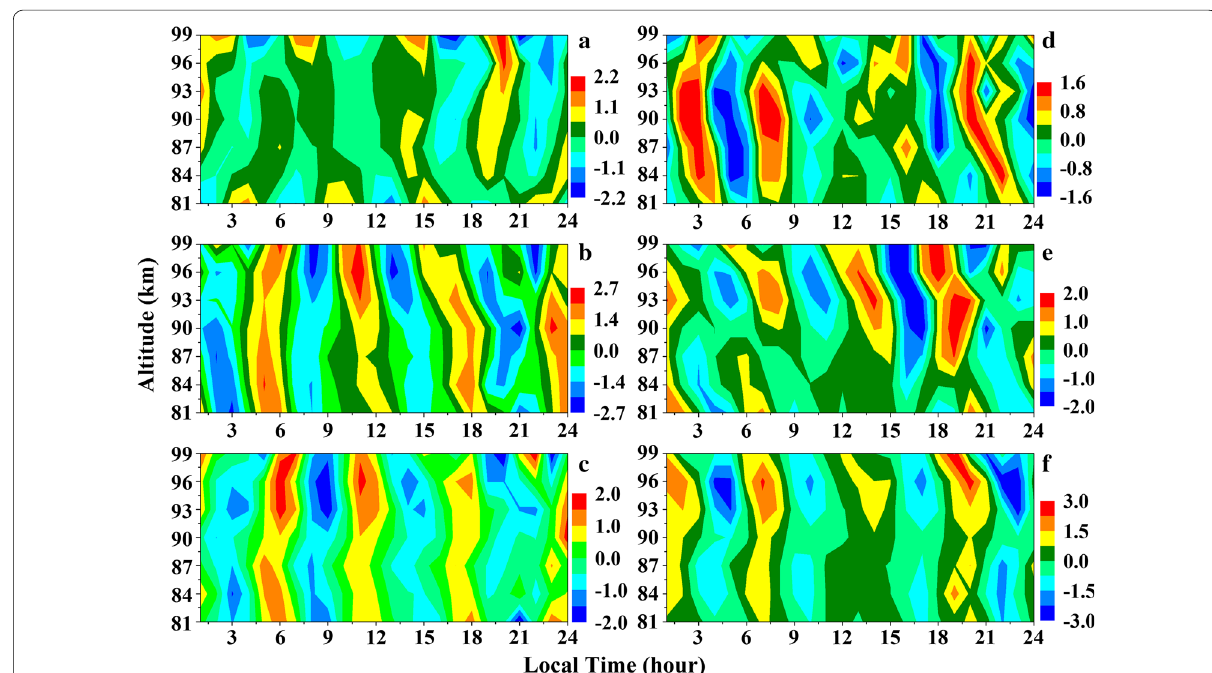
Fig. 2 Daily composite mean wind profiles in 2005 undergone high-pass filter with cutoff at 7 h are shown for a zonal wind at CA, b zonal wind at CP, c zonal wind at SM, d meridional wind at CA, e meridional wind at CP and f meridional wind at SM